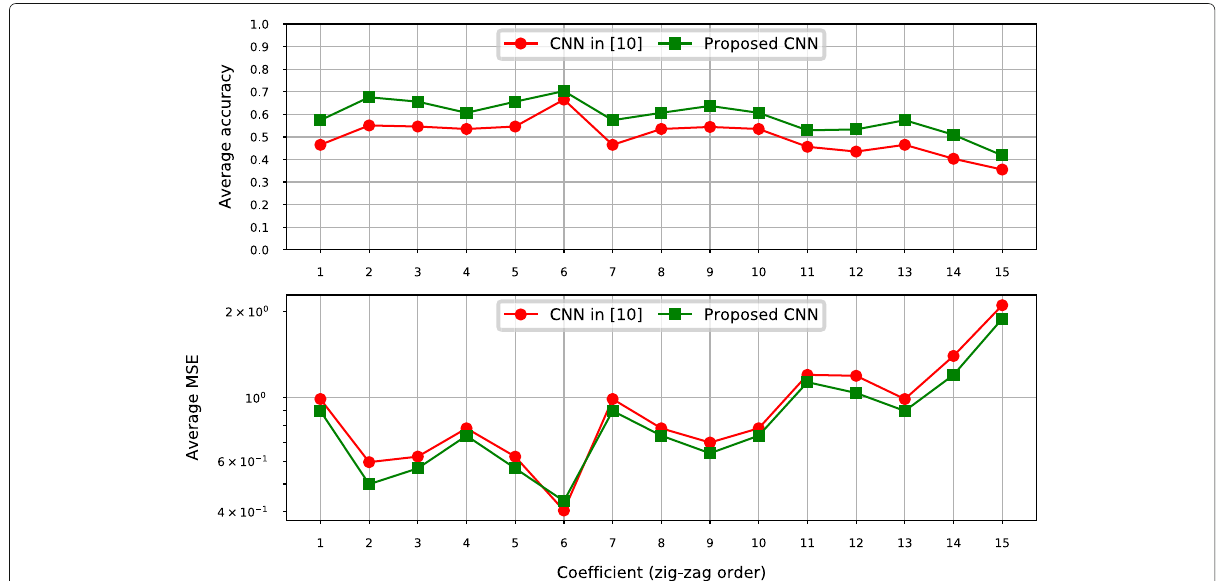
Fig. 8 Performance of the CNN estimator under mismatched QF 2 ( QF 2 = 92). Average accuracy (top) and MSE (bottom) of the estimation for each of the 15 DCT